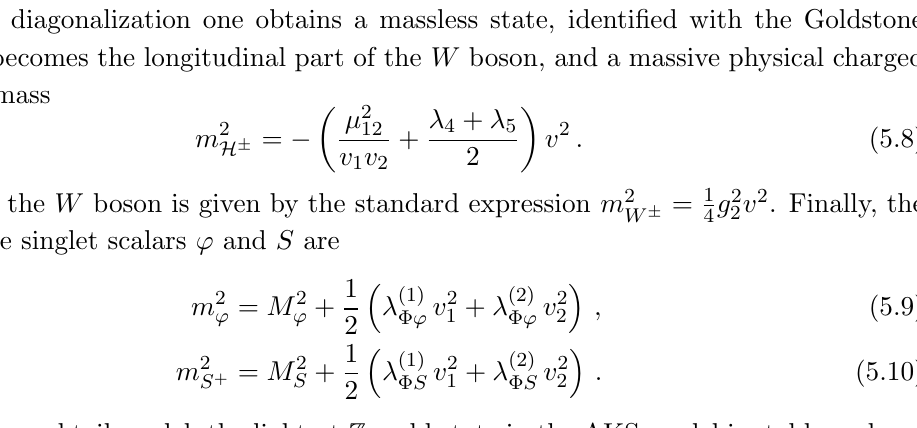
Figure 11 . 3-loop neutrino masses in the AKS model. scalars in the model, obtained after diagonalizing the mass matrix of the Again, after diagonalization one obtains a massless state, identi(cid:12)ed with the